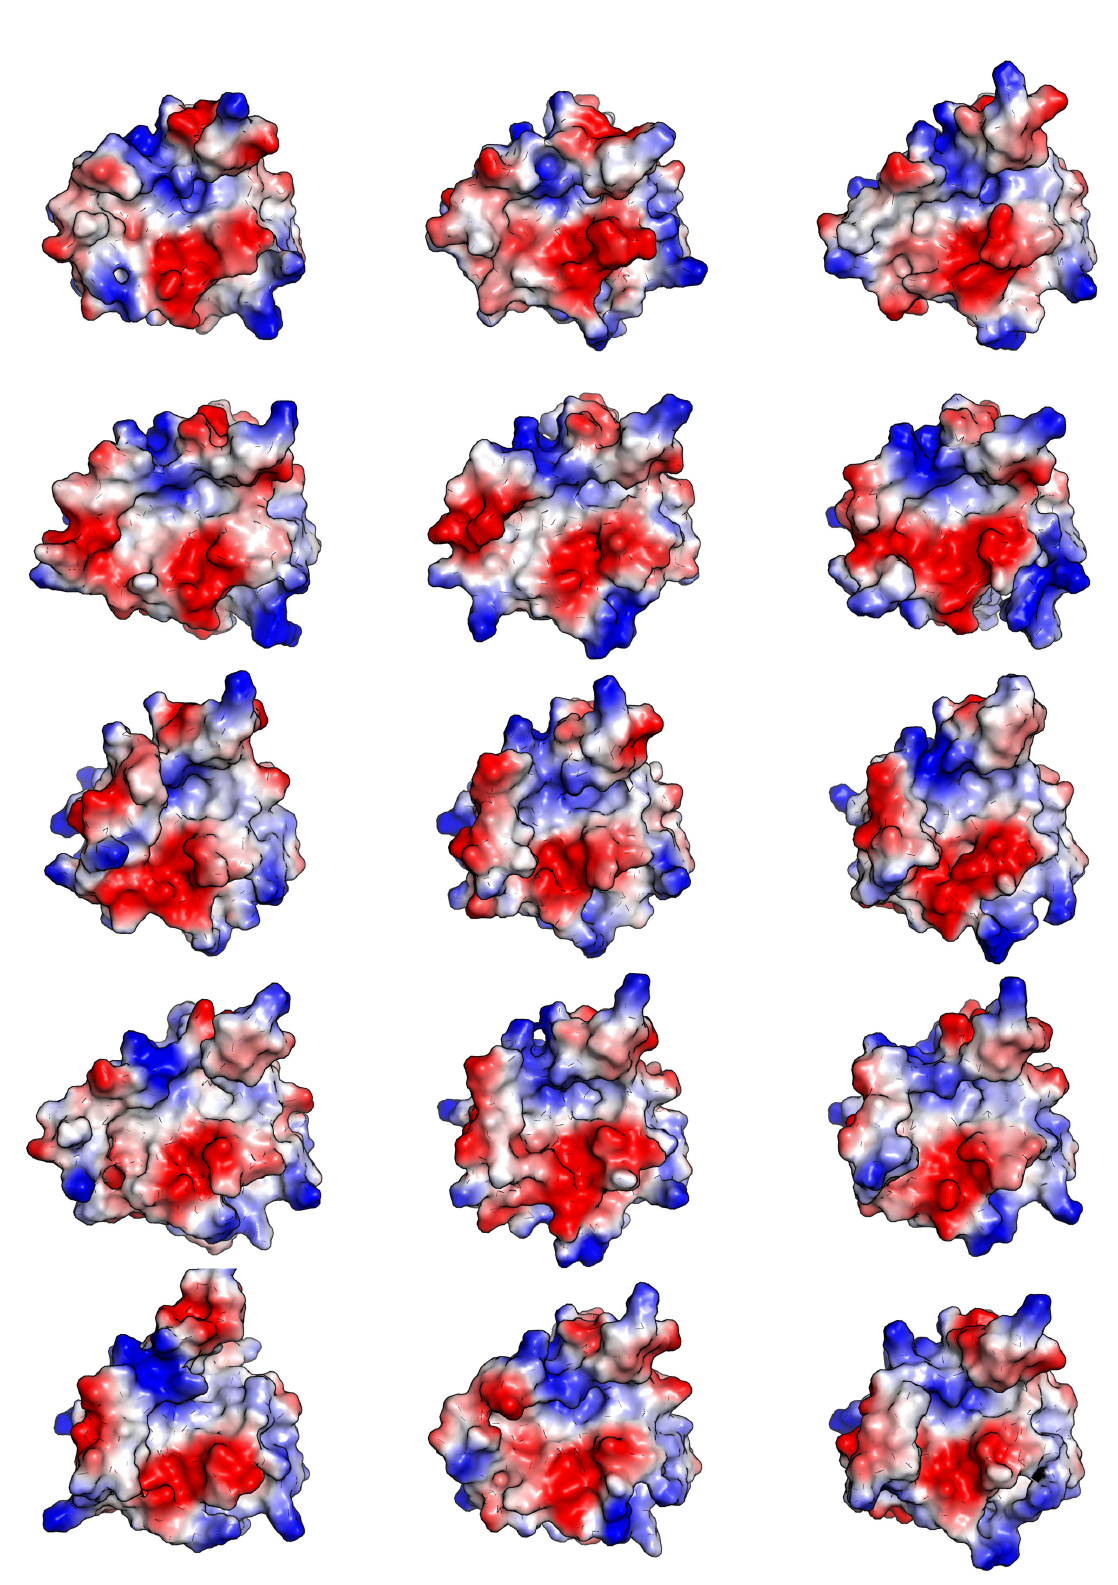
Figure 5. Different shape and electrostatic patterns of the effective binding site surfaces of SrtA obtained from MD simulation (eight complexes × three replicas each). The same alignment to the initial structure PDB:1T2W as in Figure 4 is used. Negative electrostatic potential is in red, positive potential is in